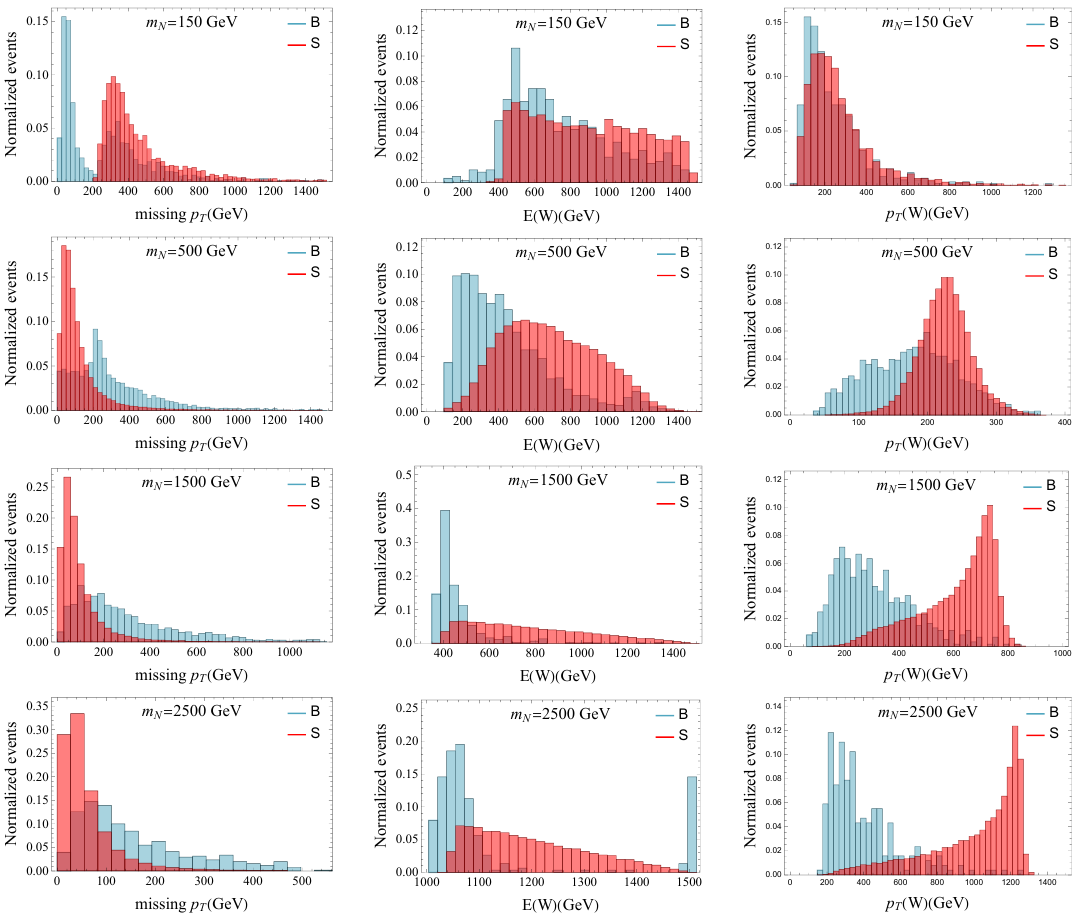
Figure 4 . The normalized signal and background distributions µ -flavored HNL at 3 TeV. The left column refers to the missing p T distribution after pre-selection and central W cut. The middle column refers to E ( W ) distribution after missing p T cuts. The right column refers to p T ( W ) distribution after E ( W ) cut. Blue and red bins represent background and signal distributions, respectively.